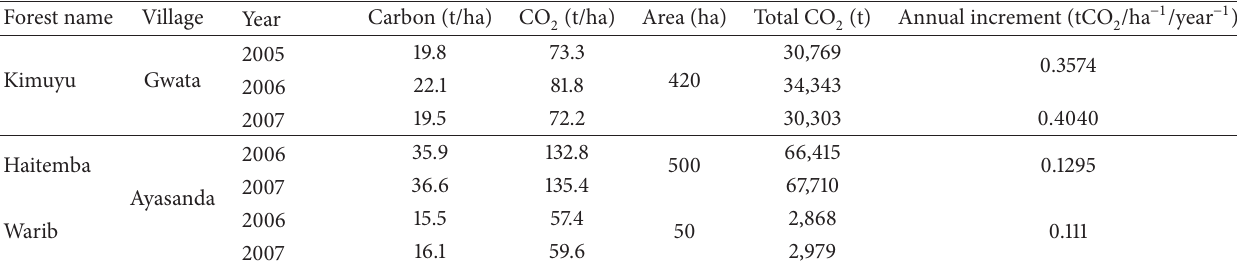
Table 4: Carbon stock annual increments in selected miombo woodland under PFM.